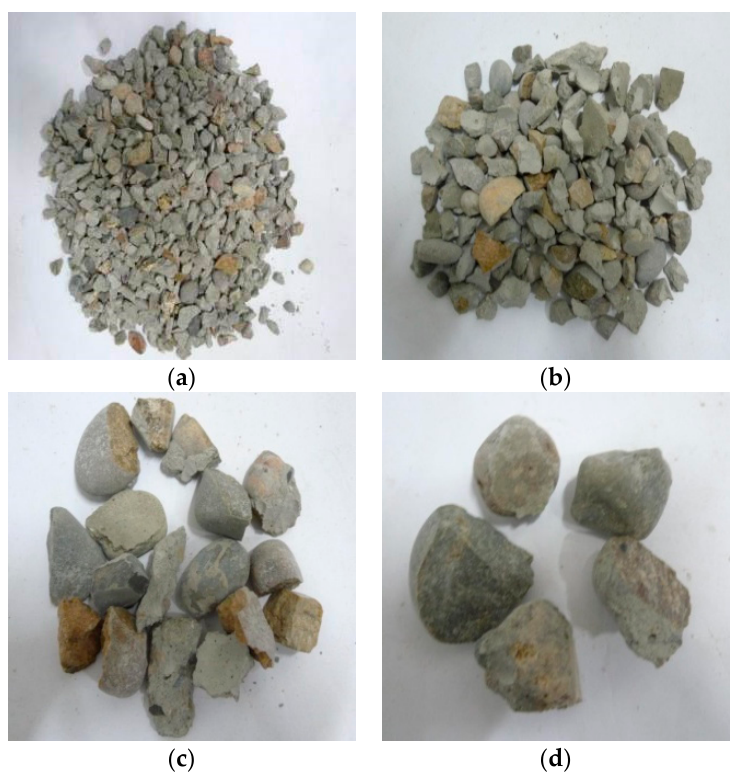
Figure 5. Concrete particles after slow heating up to 200 °C and sieving (impact speed 8.6 m/s), water cooling. ( a ) 5 mm (41.97%); ( b ) 10 mm (37.07%); ( c ) 16 mm (8.93%); ( d ) 20 mm (11.89%).